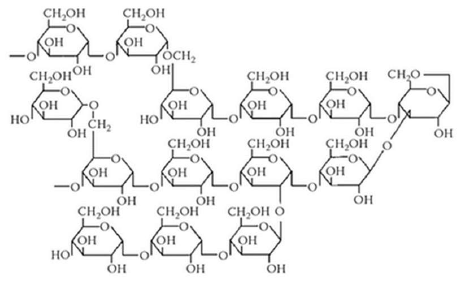
Figure 1. RMD chemical structure model.